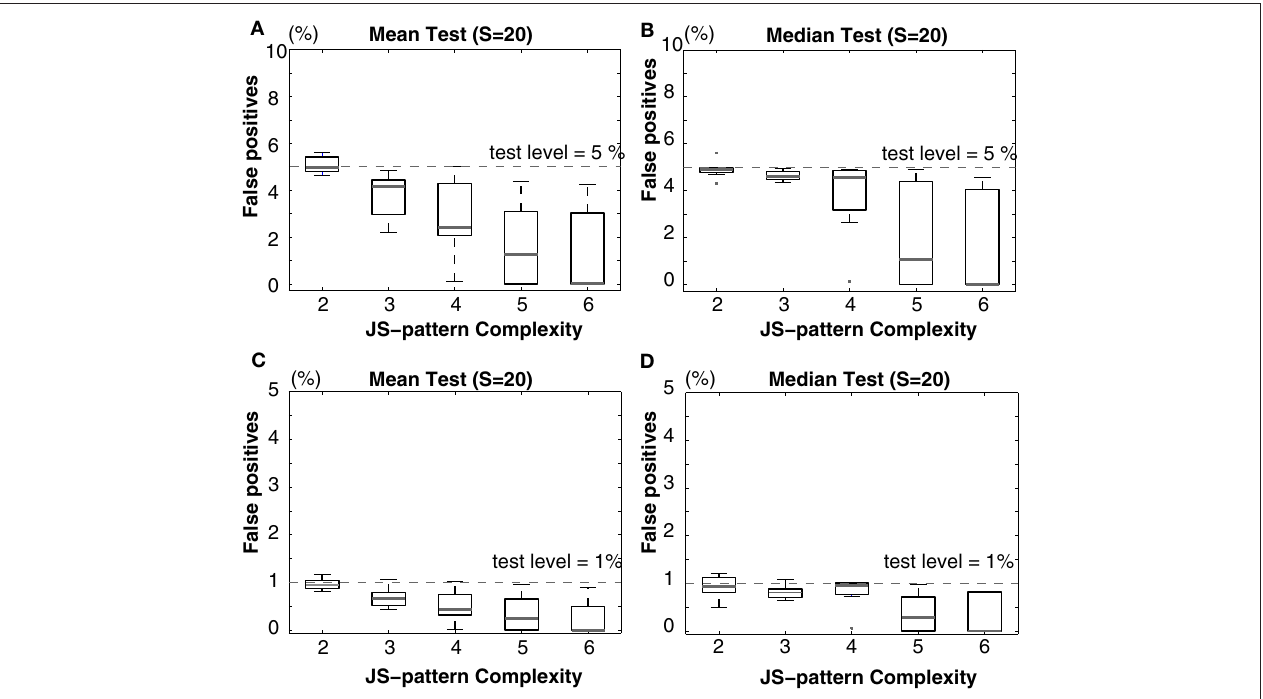
used to test the medians. The standard set of parameters is defined by 50 trials ( T ), a mean spike rate of 15 spikes/s ( r ), 20 surrogates samples ( S ), and h equals 5. From the standard parameter set, eight different combinations of parameters were derived by varying, in turn, the number of trials ( T = 20, 50, 100) and the mean spiking rates ( r